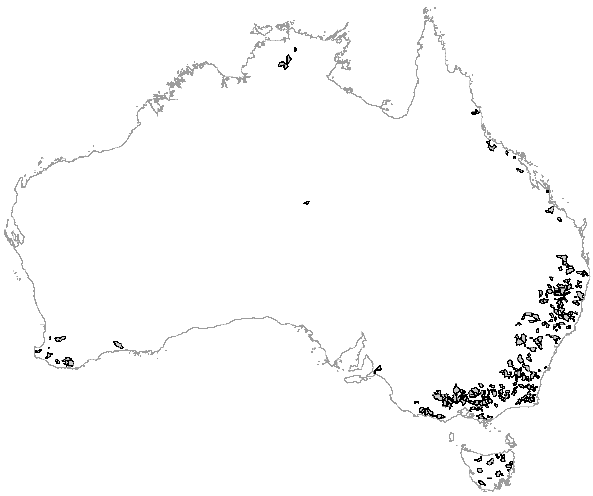
Fig. 1. Location of the 278 Australian catchments for which streamflow data were used in the analysis. 768